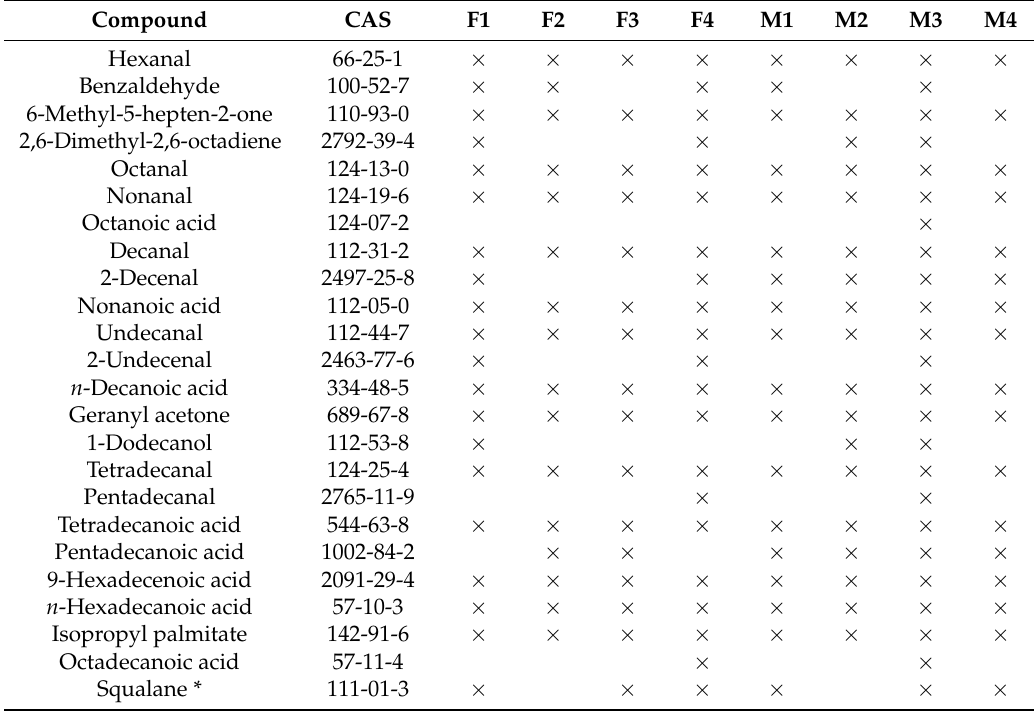
Table 1. Compounds identified in the skin headspace of human participants after 15 min sample collection using a wearable concentration method employing headspace solid-phase microextraction (HS-SPME) followed by thermal desorption to gas chromatography-mass spectrometry (GC-MS). Compounds are shown in order of increasing retention time, where × indicates the presence of a compound in a sample. (F—female,